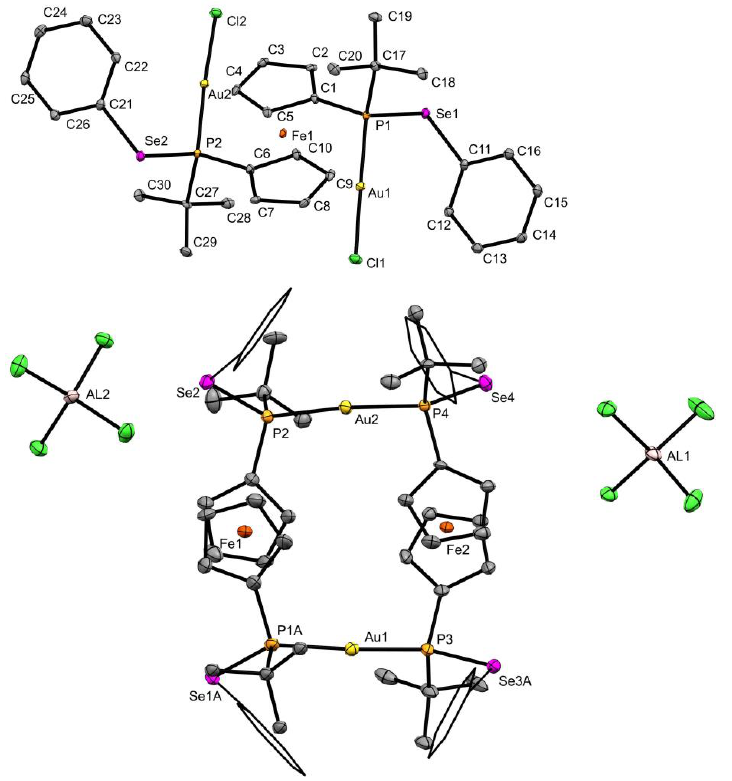
Figure 6. Molecular structure of 7 ( top ) and 8 ( bottom ) in solid state. Ellipsoids are shown at 30% probability, and all hydrogen atoms have been omitted for clarity. The phenyl substituents at Se1A, Se2, Se3A, and Se4 in 8 are indicated as wireframe for better overview. The phosphorus (P1) and selenium atoms (Se1 and Se2) as well as the tert- butyl- and phenyl substituents at these atoms showed a disorder over two positions in 8 , which is not shown in the figure. Selected bond lengths and angles of 7 : Se1-P1 2.2541(10) Å , Se2-P2 2.2546(10) Å , Au1-P1 2.2277(9) Å , Au2-P2 2.2307(9) Å , Au1-Cl1 2.2741(9) Å , Au2-Cl2 2.2840(9) Å , torsion angle τ = 177.44° and 8 : Se1A-P1A 2.277(8)Å , Se2-P2 2.234(2) Å , Se3A-P3 2.135(4) Å , Se4-P4 2.2332(19) Å , Au1-P1A 2.337(9) Å , Au1-P3 2.314(2) Å Au2-P2 2.3104(17) Å , Au2-P4 2.3131(17) Å , P3-Au1-P1A 173.95(18)°, P2-Au2-P4 174.91(6)°.